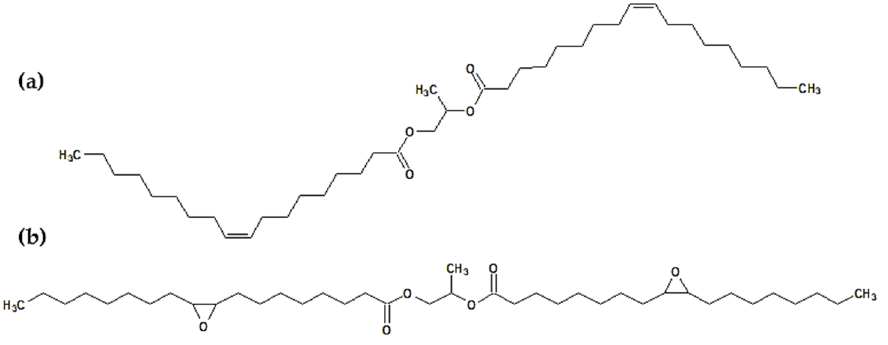
Figure 3. The chemical structure of ( a ) propylene glycol dioleate and ( b ) epoxidized propylene glycol dioleate.